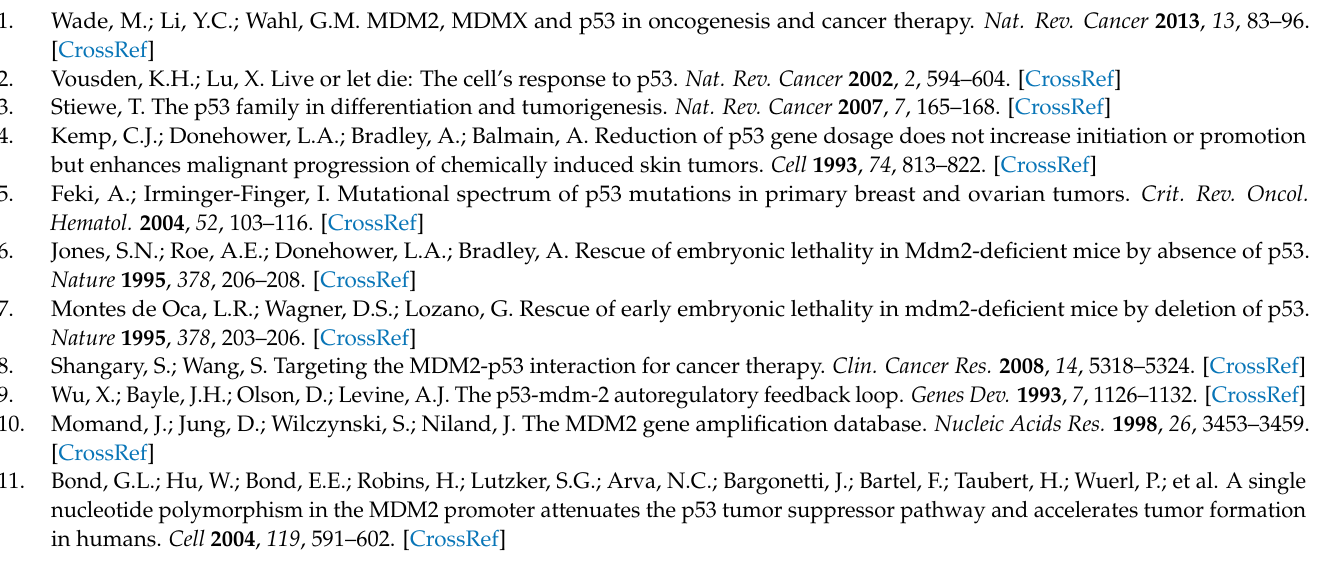
NMR spectra, Figure S1: 1 H NMR spectrum of dispiro-indolinone 27, Figure S2: 1 H- 1 H COSY NMR spectrum of dispiro-indolinone 27, Figure S3: 1 H- 13 C HSQC spectrum of dispiro-indolinone 27, Figure S4: 1 H- 13 C HMBC spectrum of dispiro-indolinone 27, Figure S5: The mechanism of cell death (necrosis/apoptosis) caused by compound 12 by flow cytometry staining with 7AAD/AnnexinV, Figure S6: Representative protein gels after 2D electrophoresis, Table S1: Proteins with changed level, determined from 2D-difference gel electrophoresis, Table S2: Anticancer effect of compound 29 achieved after p.o. dose of 170 mg/kg (o.d., 10 days) in P388-inoculated mice, Table S3: Acute toxicity study design for compound 29, Table S4: Dynamics of body weight of mice in the study of acute toxicity of compound 29, Table S5: Average group indicators of the relative mass of the internal organs of mice in the study of acute toxicity of the compound 29 . References [85,86] are cited in Supplementary